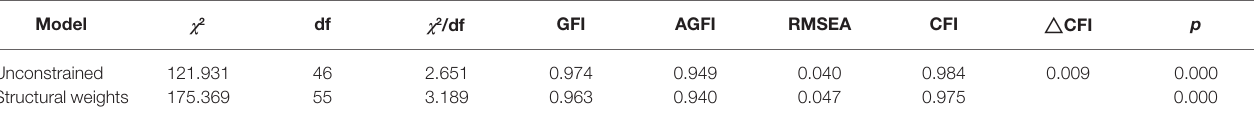
TABLE 5 | Multiple comparison model fitting